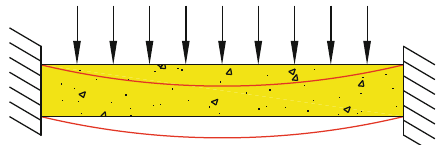
Figure 9: Displacement calculation sketch of the stratum between the tunnel and karst caves.